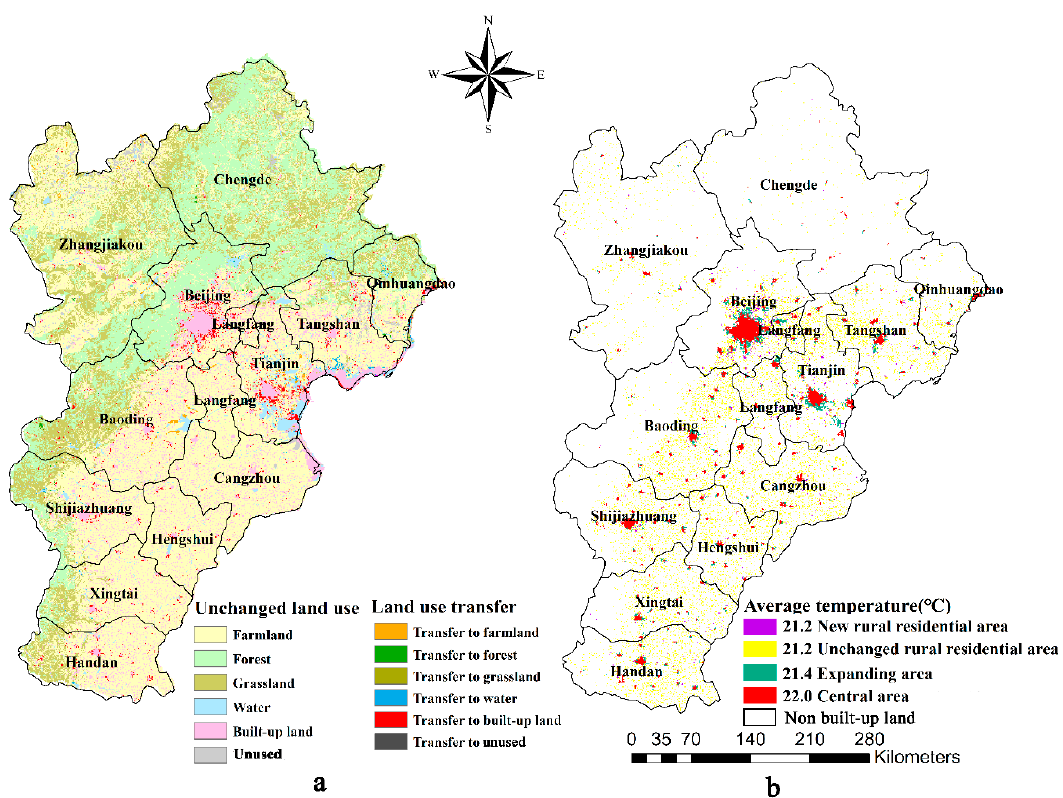
Figure 2. Land-use and transfer from 2000 to 2015 and an annual average temperature of land-use types. ( a ) Land-use change comparing 2000 and 2015; unchanged land-use cover, shown in a light color, and land changed to other land-use types, shown in a bright color. ( b ) Built-up land was divided into four types: Central, expanded, unchanged rural residential, and new rural residential areas, and the average temperature of the four types during 2000–2015 is shown.